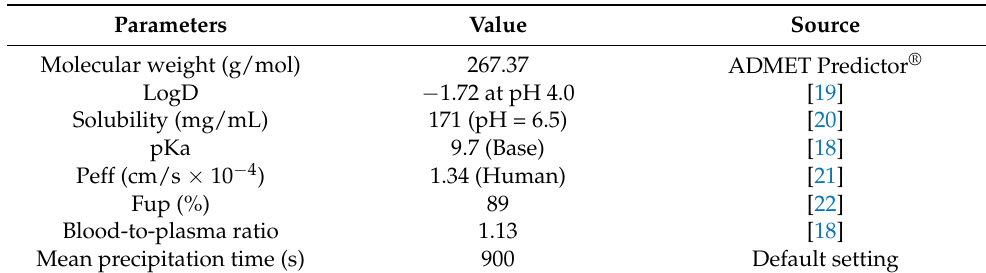
Table 4. Summary of the key physicochemical and biopharmaceutical properties used to build the PK model of metoprolol in GastroPlus ®